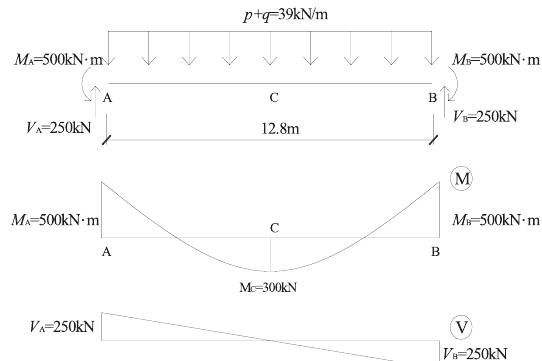
Fig. 5. Simplified computing sketch of SRC beam.